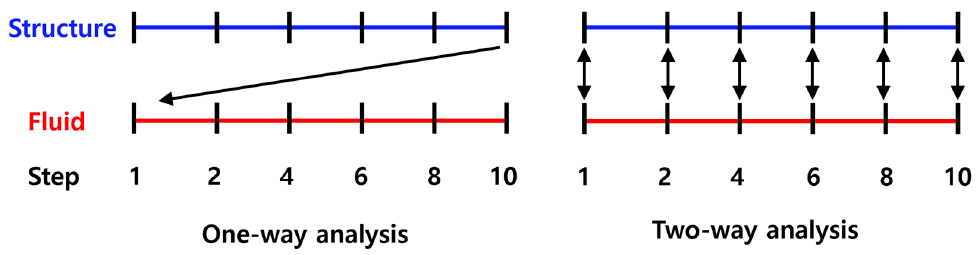
Figure 2. Schematic of the fluid structure interaction (FSI) analysis method.